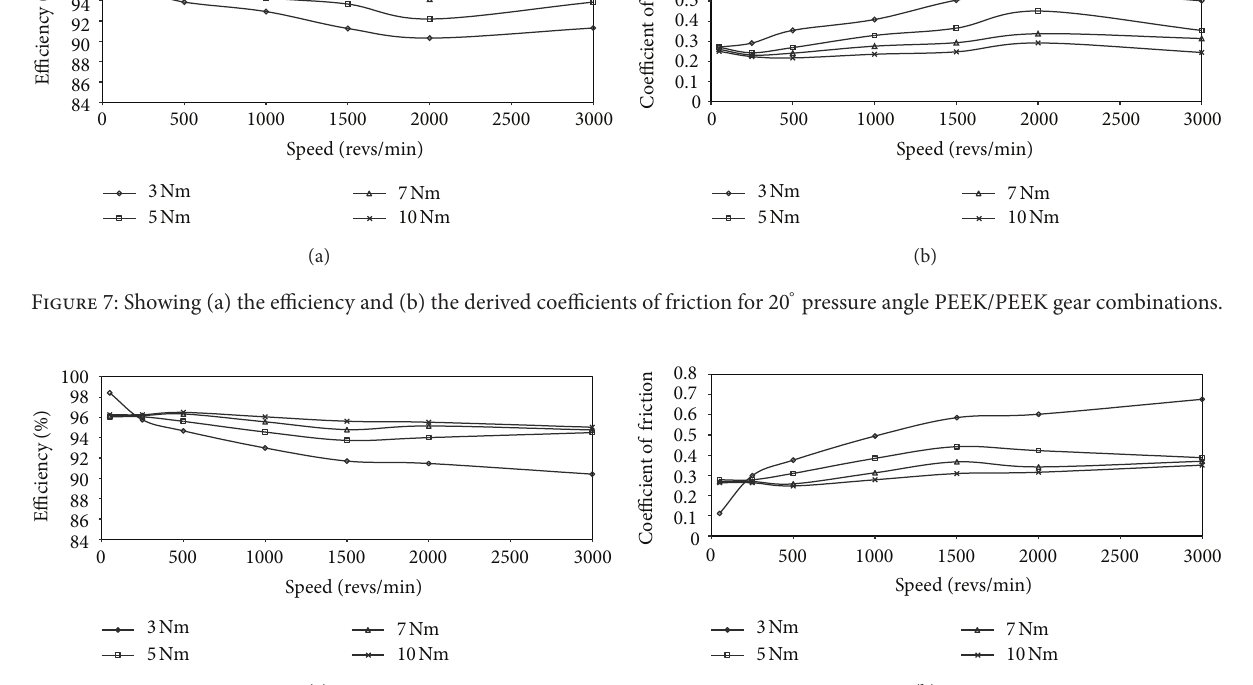
pressure angle PEEK/PEEK gear ∘